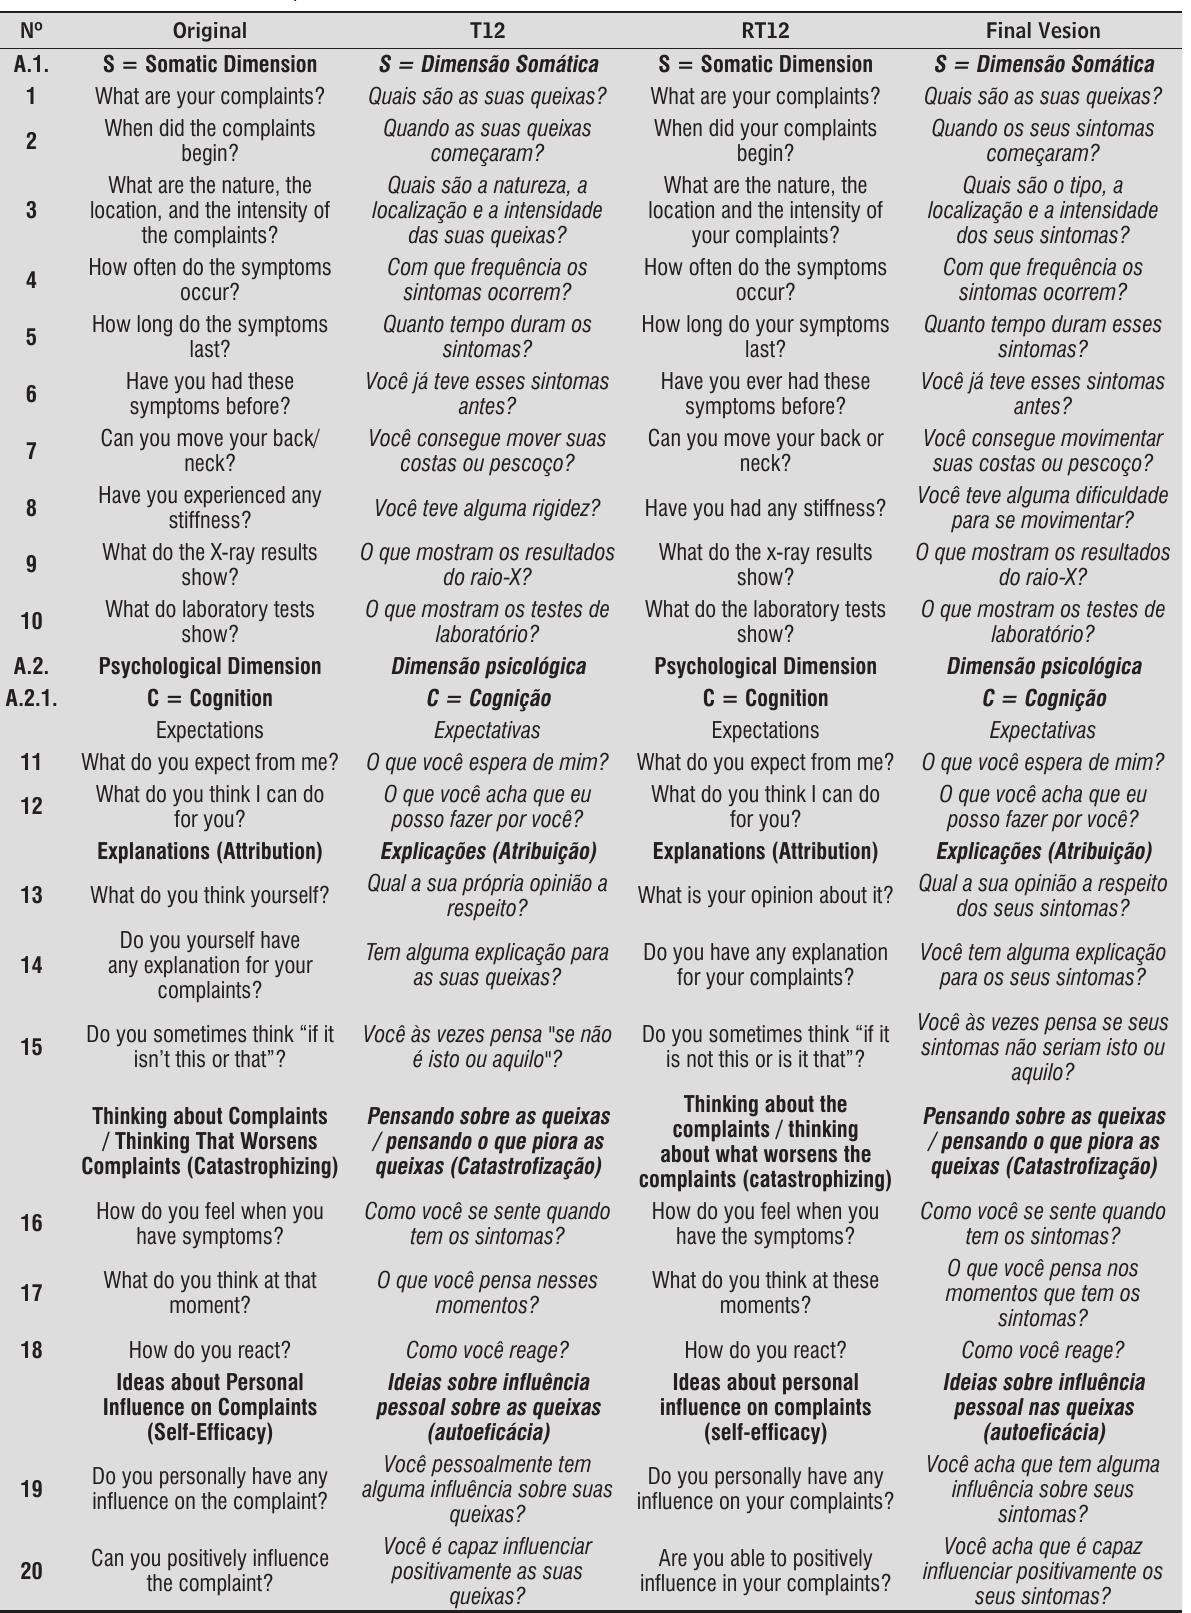
Table 1 - The transcultural adaptation of the SCEBS